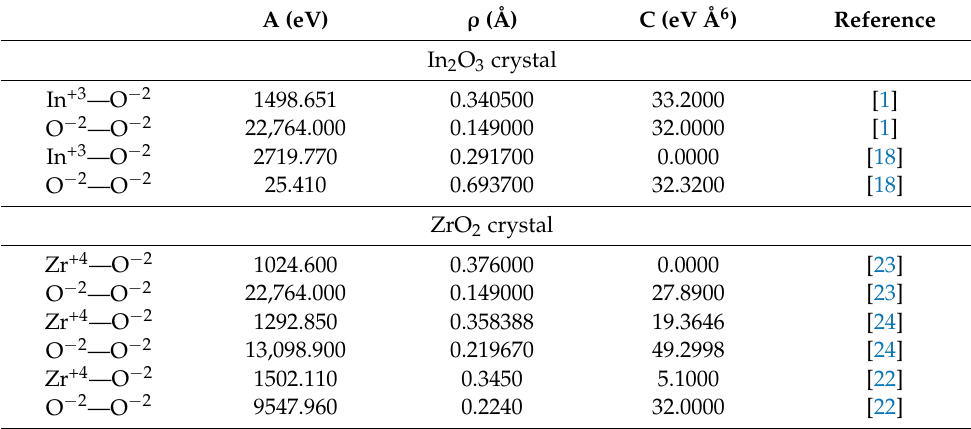
Table 3. Interatomic potentials used for the present calculations.